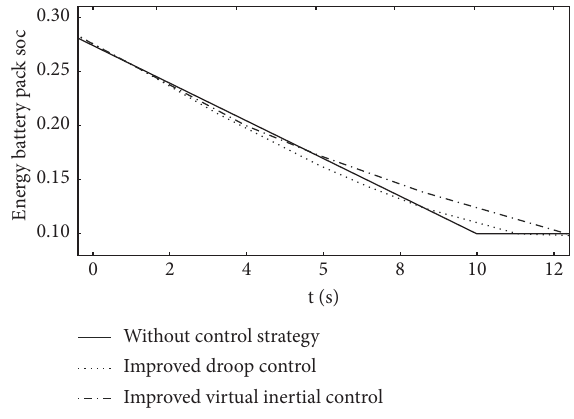
Figure 12: SOC of partial battery